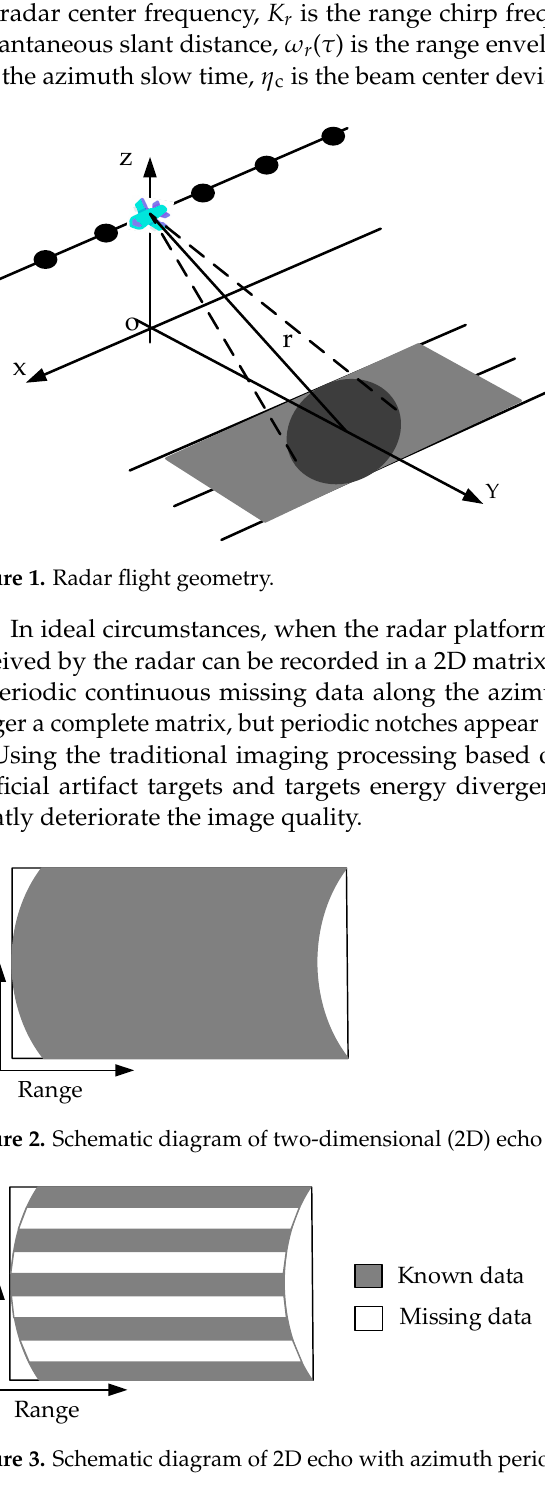
Figure 3. Schematic diagram of 2D echo with azimuth periodic missing data.